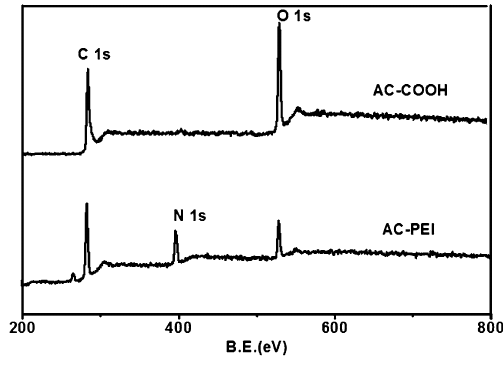
Fig. 2 XPS survey spectra of AC-COOH and AC-PEI